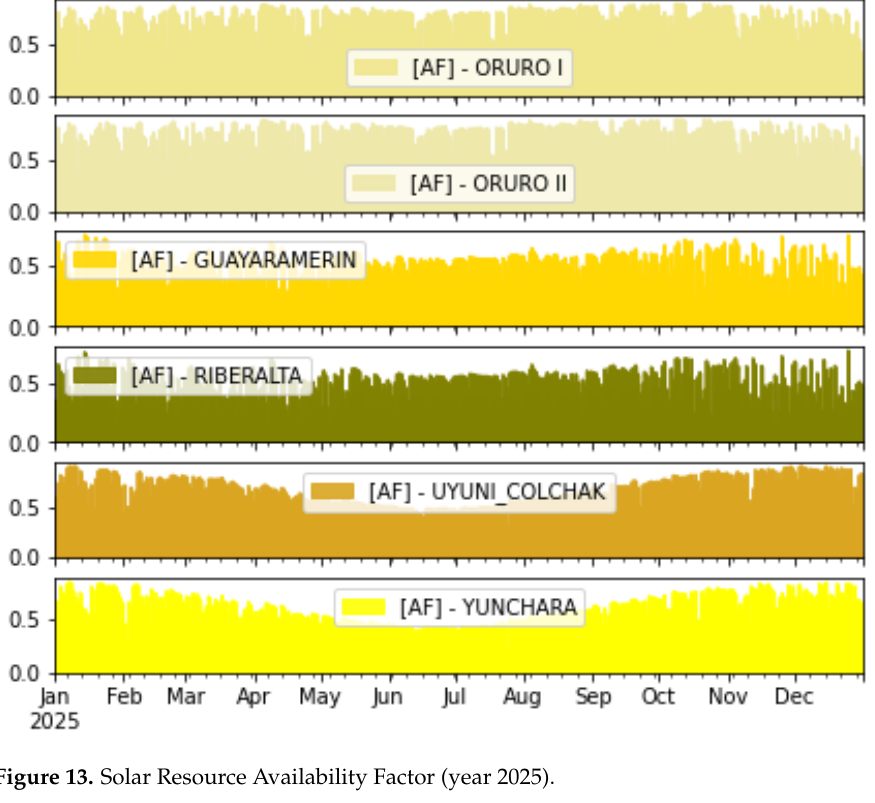
Figure 13. Solar Resource Availability Factor (year 2025).